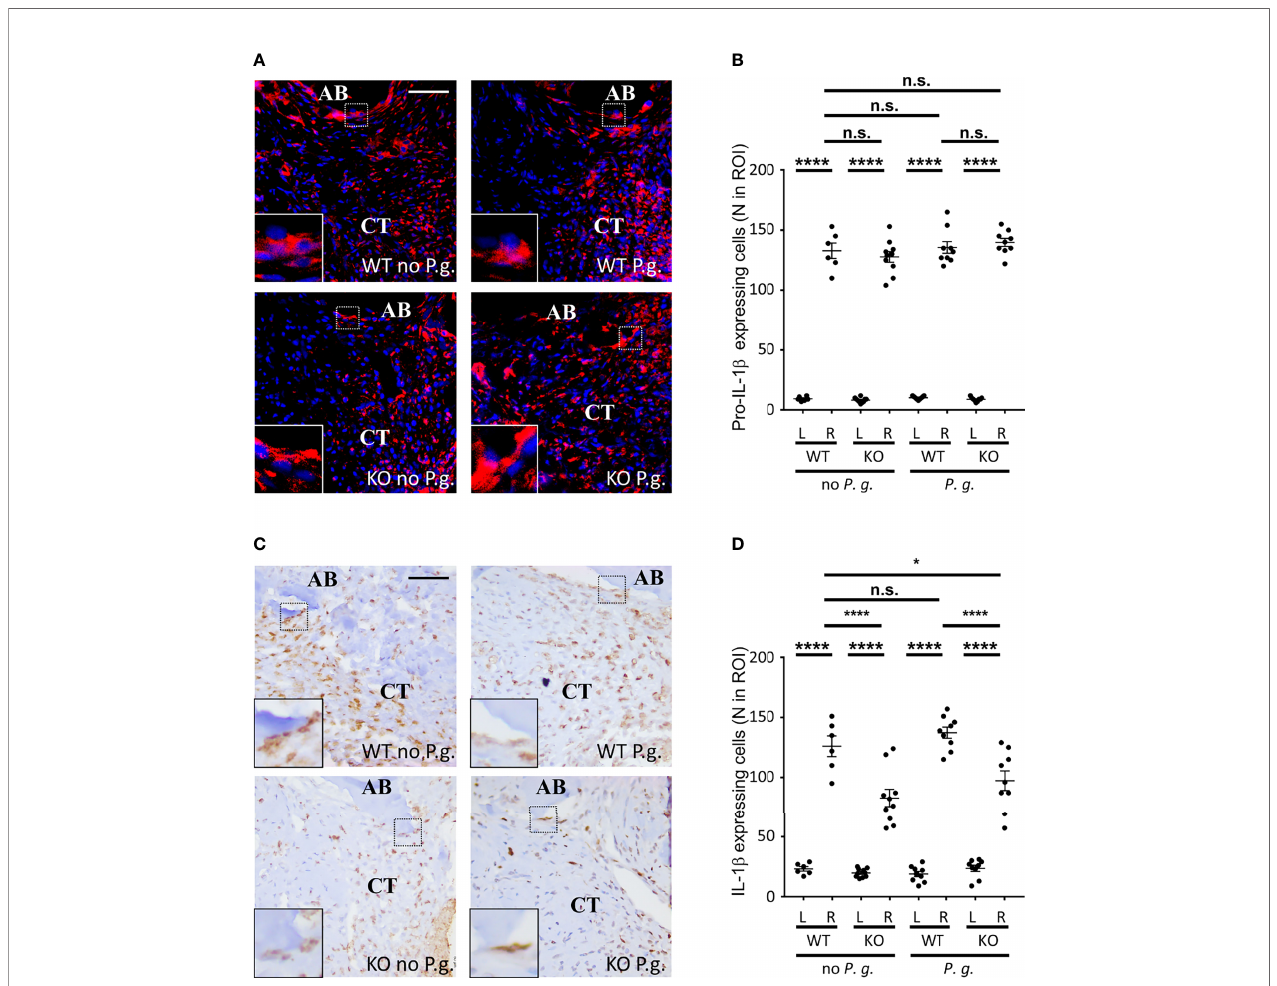
FIGURE 6 | NLRP3 expression is necessary for an optimal IL-1 b cleavage. (A) Pro-IL-1 b protein expression was revealed by immuno fl uorescence using a speci fi c antibody targeting the immature form. Enlargements show cells expressing pro-IL-1 b along alveolar bone. (B) The number of pro-IL-1 b -expressing cells was counted in a 0.082 mm 2 area (ROI) surrounding the alveolar bone crest. (C) IL-1 b protein expression was revealed by immuno fl uorescence using a speci fi c antibody targeting the mature form. Enlargements show cells expressing IL-1 b along alveolar bone. (D) The number of mature IL-1 b -expressing cells was counted in a 0.082 mm 2 area (ROI) surrounding the alveolar bone crest. (B, D) Each dot represents a single mouse. Horizontal bars represent the mean +/- SEM. Ordinary one-way ANOVA followed by uncorrected Fisher ’ s LSD with a single pooled variance multiple comparison test. *P < 0.05, ****P < 0.0001, n.s. P ≥ 0.05, non-signi fi